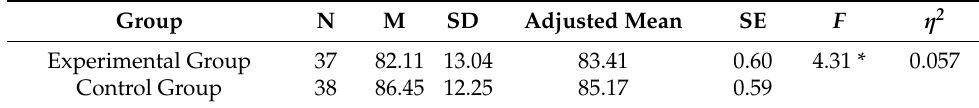
Table 1. The ANCOVA result of learning effectiveness.